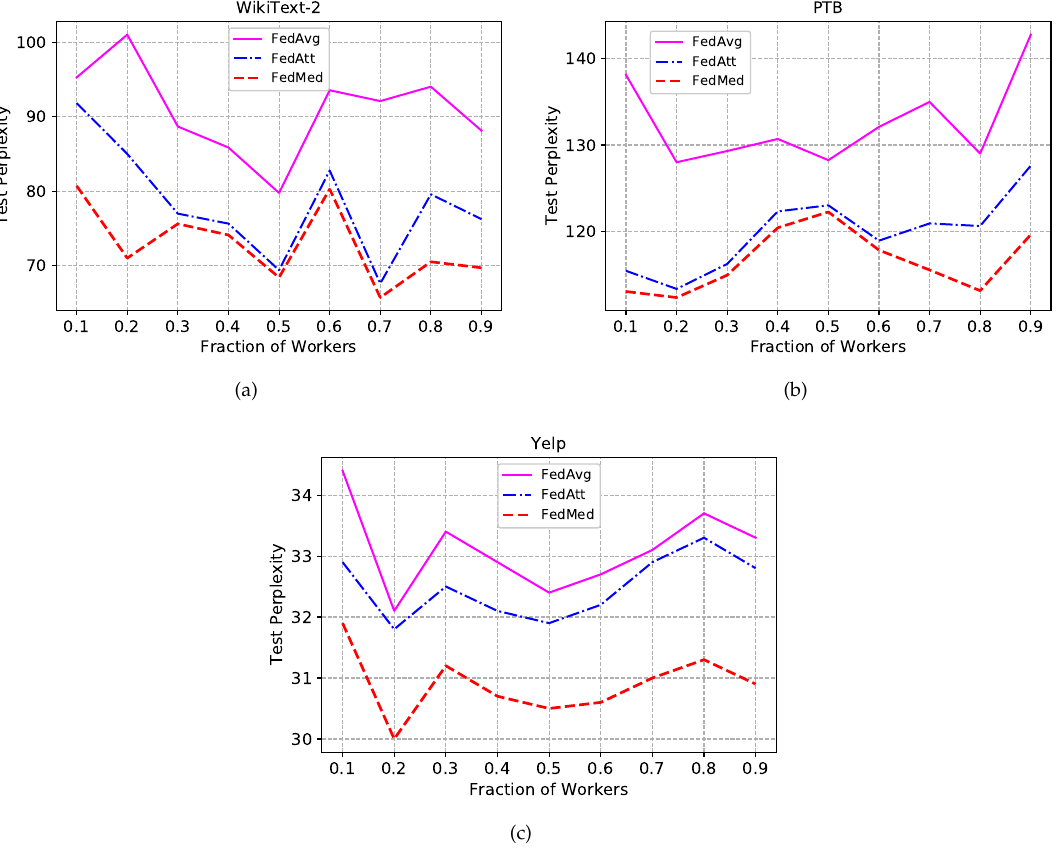
Figure 4. Experimental results of different aggregation methods on test sets. ( a )Test perplexity on test set of WikiText-2. ( b )Test perplexity on test set of Penn Treebank. ( c )Test perplexity on test set of